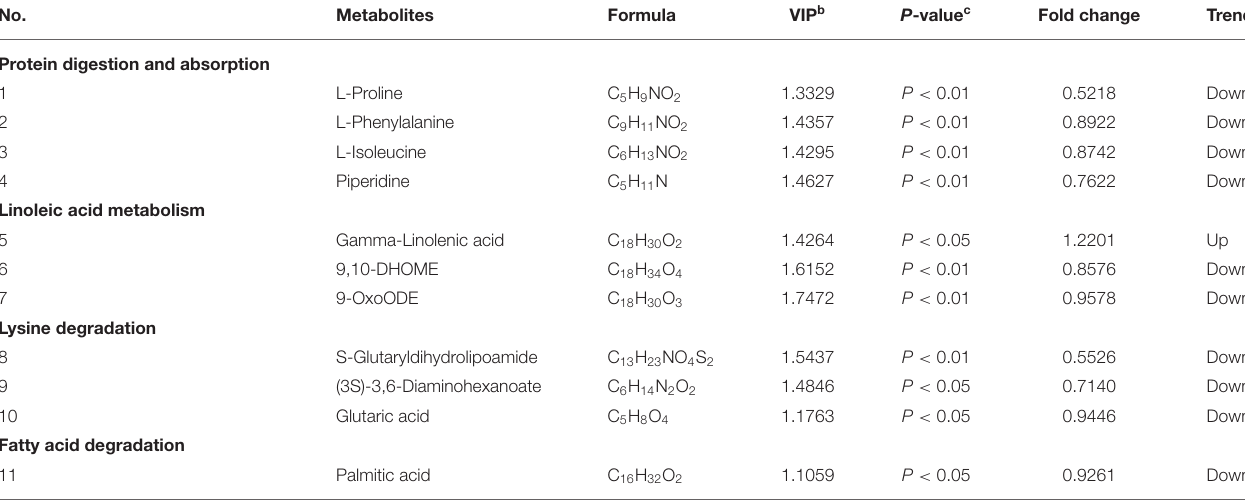
TABLE 3 | Significantly differentially ruminal metabolites of Angus heifers in the comparison between the LRFI and HRFI groups a . No. Metabolites Formula VIP b P -value c Fold change Trend d Protein digestion and